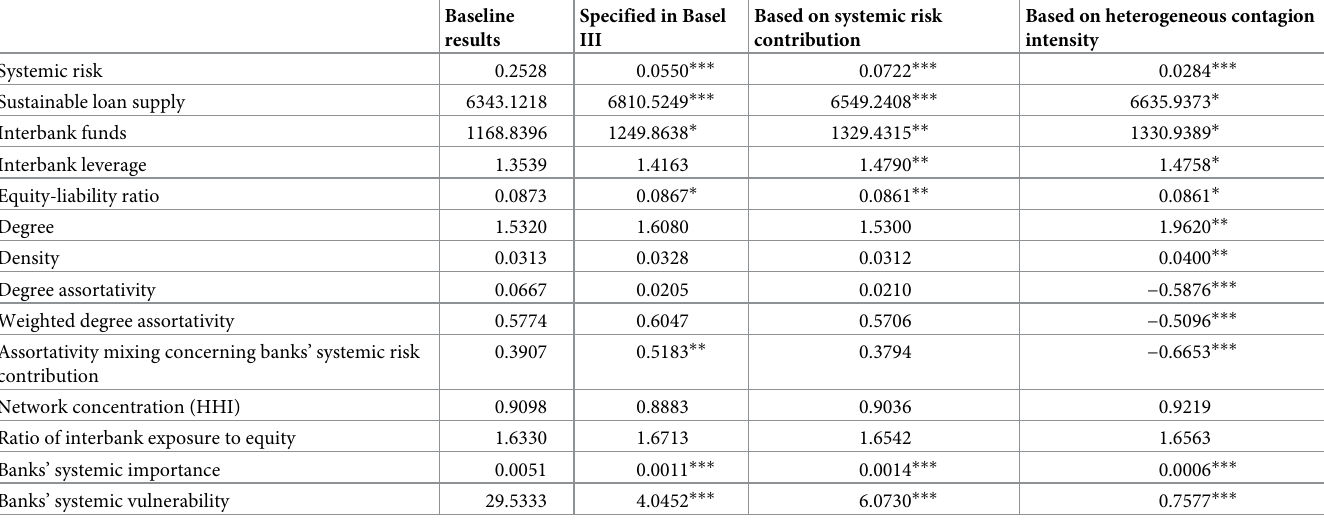
Table 7. Annually average results with the implementation of different capital